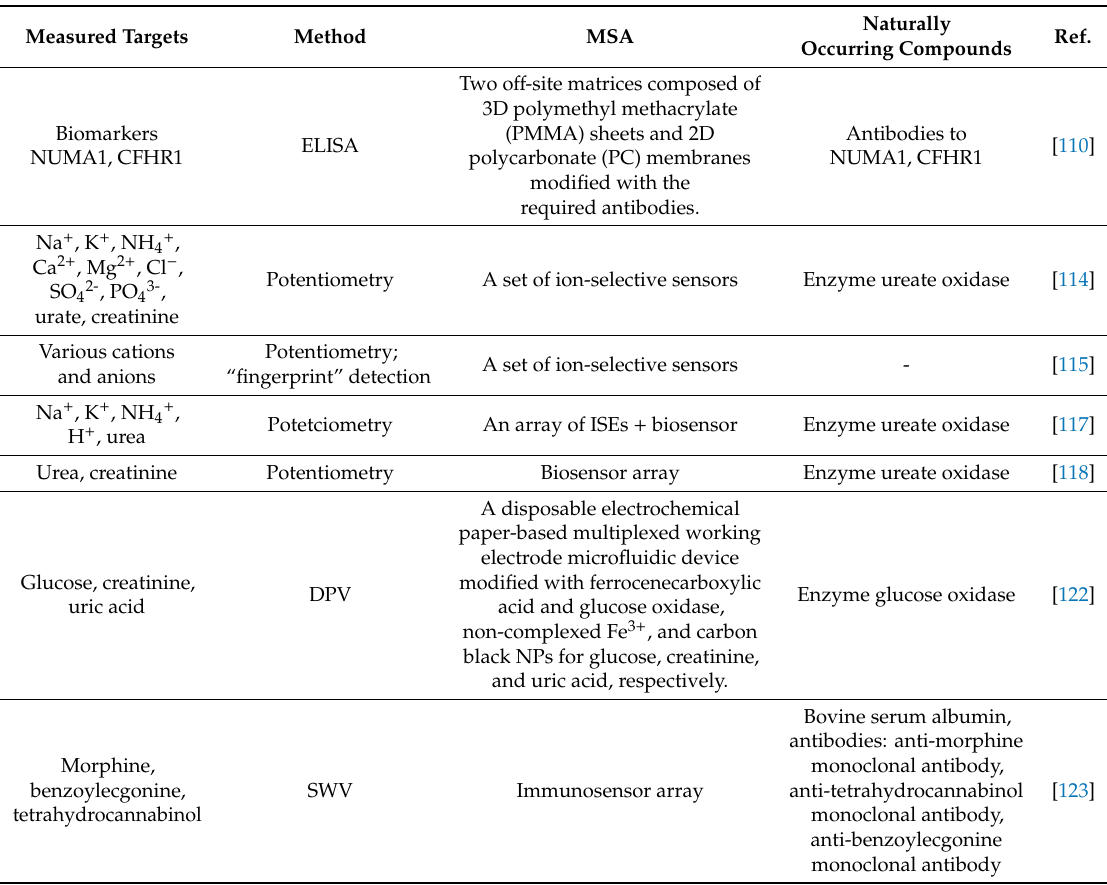
Table 2. Summary of MSS / MSA application for analysis of